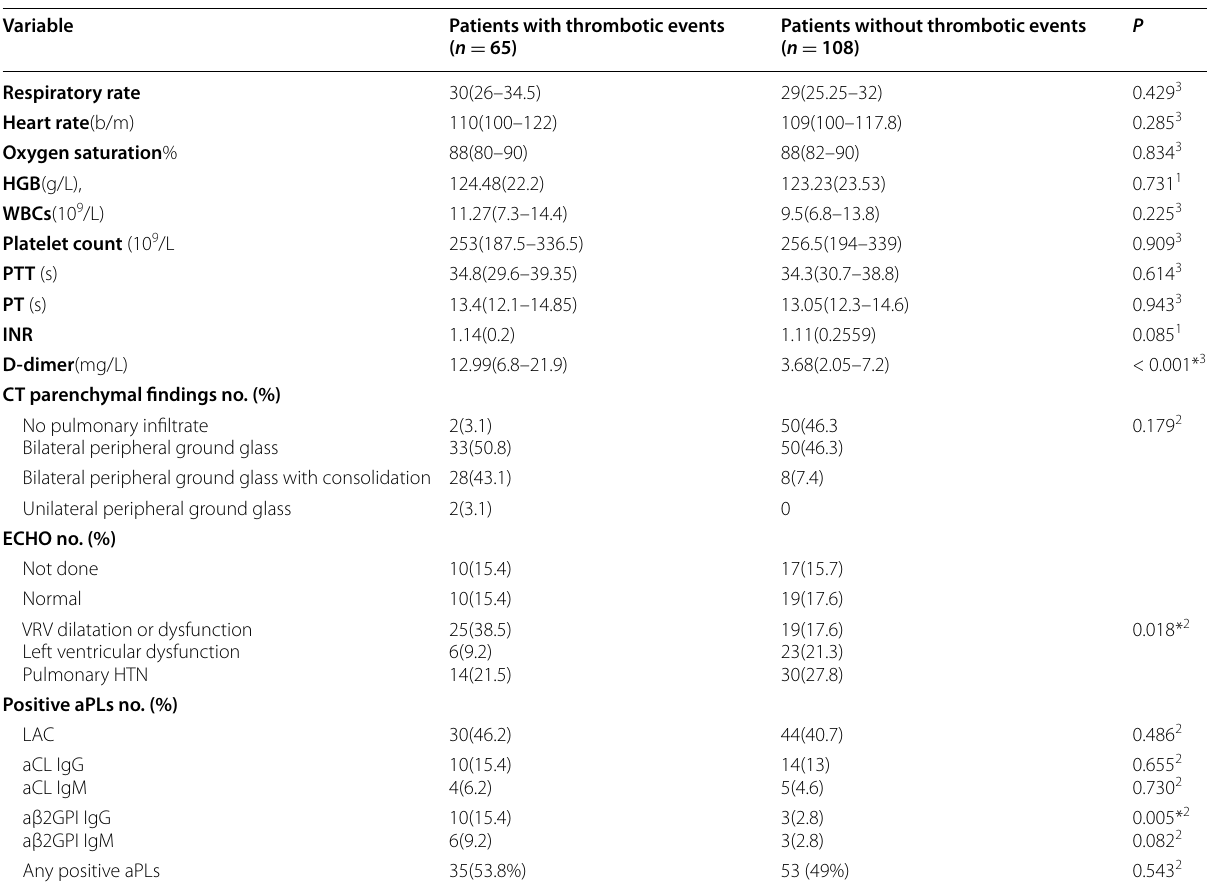
Table 3 Vital signs, blood tests, radiological finding, ECHO findings, and frequency of positive aPLs in both groups at the time of suspicion of